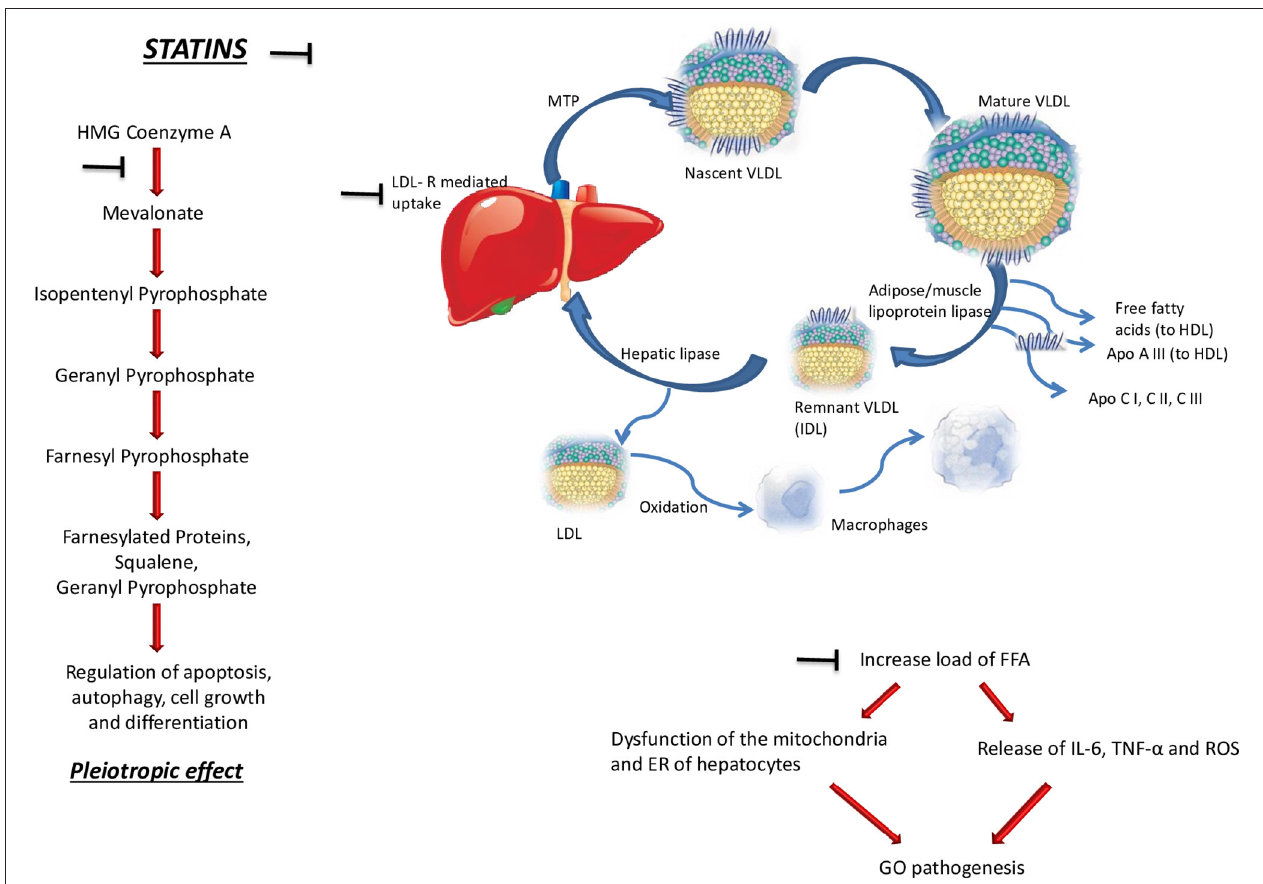
FIGURE 1 | Molecular basis for a role of cholesterol and statins in the pathogenesis of Graves’ Orbitopathy (GO). The symbol ⊣ indicates the pathways inhibited by statins, namely its pleiotropic effect in the regulation of apoptosis, autophagy, cell growth, and differentiation (left side of the figure), and the reduced synthesis of free fatty acids (upper sides of the figure). HMG, 3-hydroxy-3-methyl-glutaryl; MTP, microsomal triglyceride transfer protein; VLDL, very low density lipoproteins; HDL, high density lipoproteins; APO, apolipoprotein; LDL-R, low density lipoprotein receptor; FFAl, free fatty acids; TNF α , tumor necrosis factor α ; ROS, reactive oxygen species; ER, endoplasmic